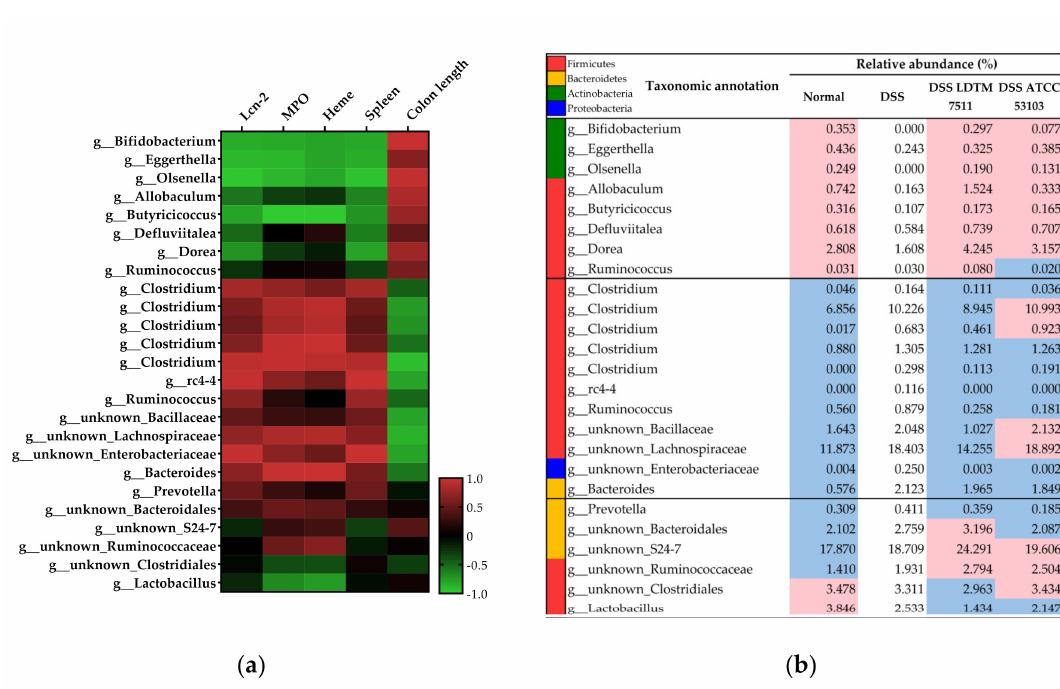
Figure 7. DSS colitis-associated bacterial taxa and their relative abundances (%). ( a ) Pearson correlation between inflammation biomarkers and bacterial taxa at a genus level (n = 32). ( b ) Relative abundance in experimental groups ( n = 8 in each group). The population values higher and lower than the DSS group are shown in red and blue,